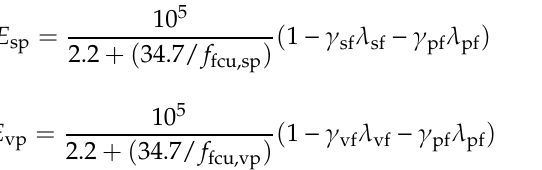
Table 3. Mean value of characteristic point on σ - ε curve.